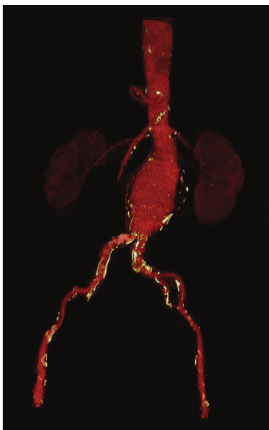
Figure 1: Preoperative angio-CT scan showing a 6 cm abdominal aortic aneurysm suitable for